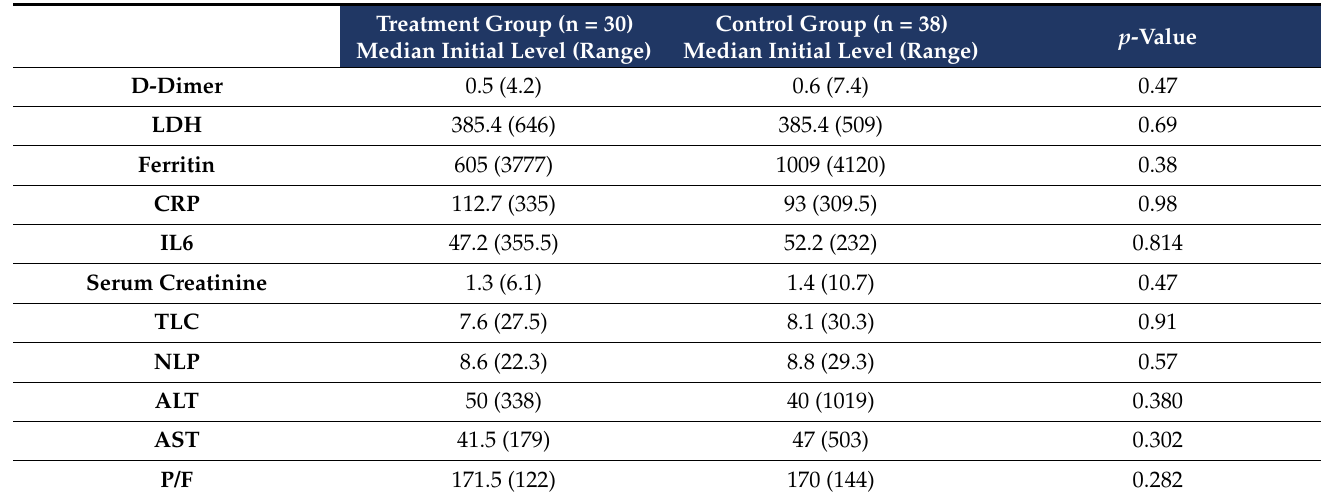
Table 2. Initial laboratory values comparison between the two groups.